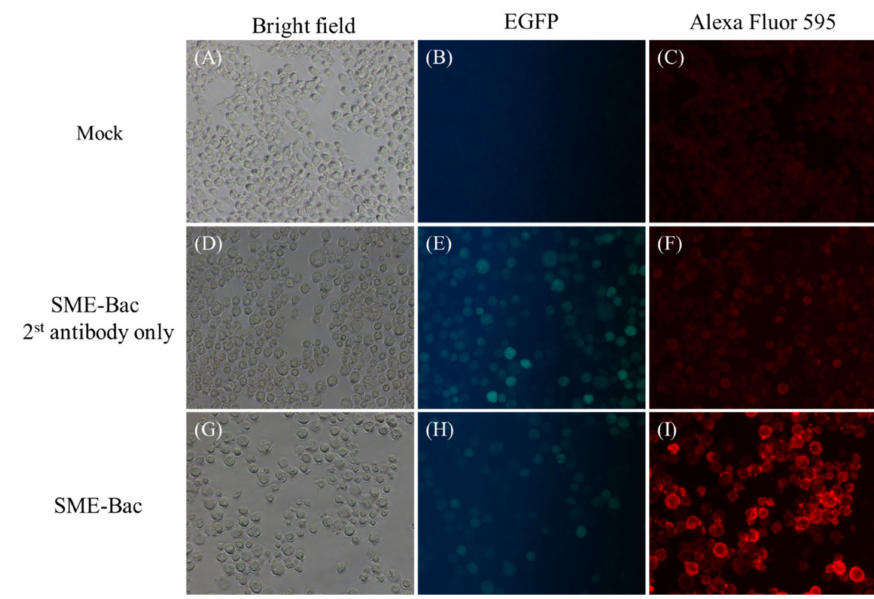
Figure 3. The detection of recombinant spike (S) proteins in SME-Bac infected cells. Sf21 cells in a total number of 2 × 10 5 cells were infected with 5 MOI of SME-Bac for 4 days. ( A , D , G ) The morphologies of the Sf21 cells with di ff erent treatments under bright field. ( B , E , H ) The Sf21 cells successfully infected by SME-Bac showed green fluorescence under fluorescent microscope. ( C , F , I ) In the indirect fluorescent assay, Sf21 cells expressing PEDV S protein displayed red fluorescent signals under fluorescent microscope. The mock-infected cells and SME-Bac-infected cells stained with secondary antibody were used as negative